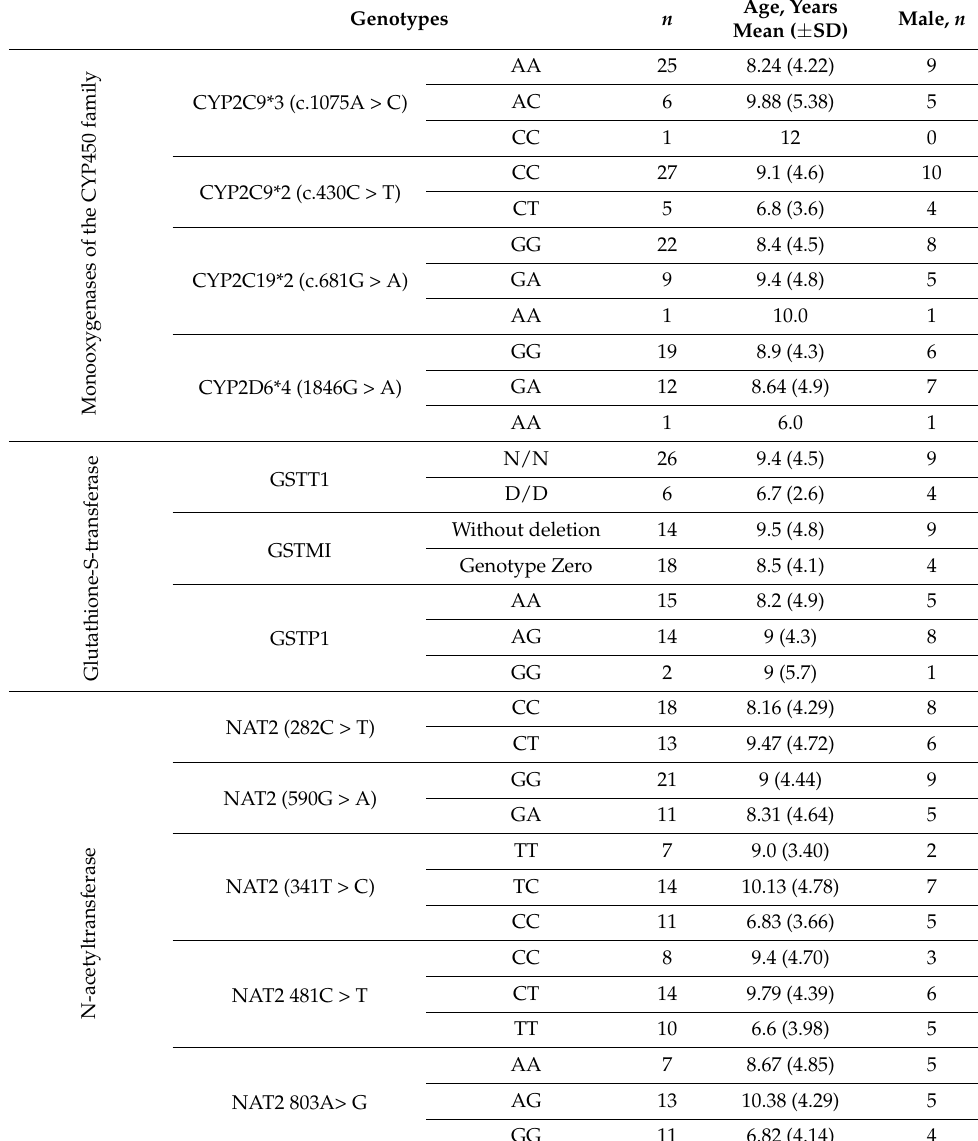
Table 3. Characteristics of patients with different genotypes of cytochrome P450 monooxygenase enzymes, glutathione S-transferases and N-acetyltransferases.